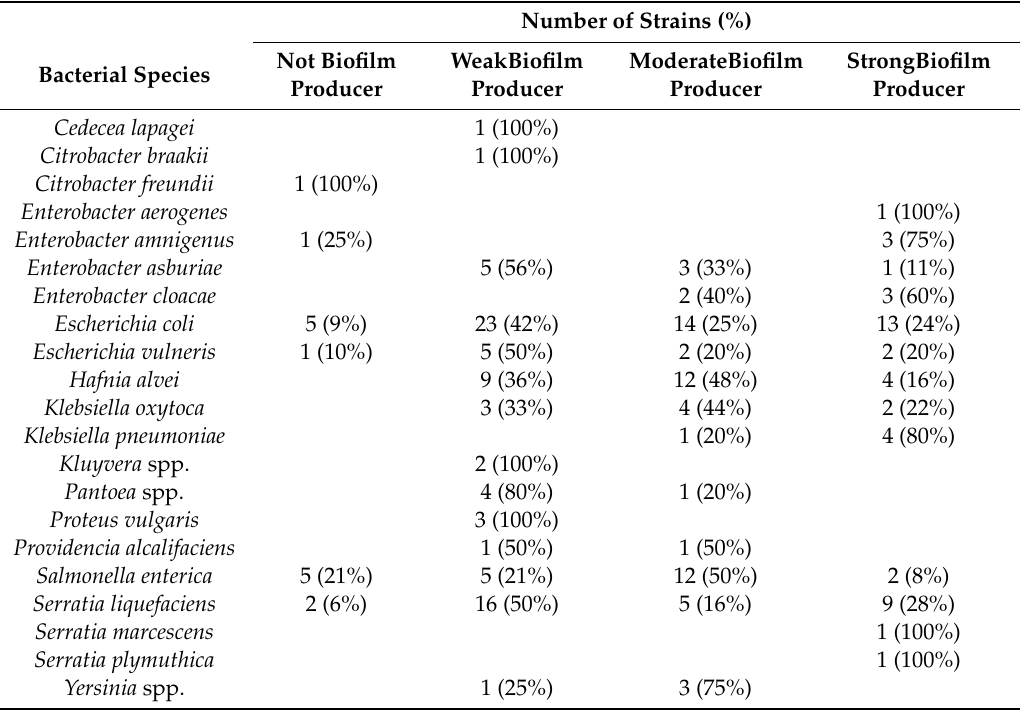
Biofilm-forming ability of di ff erent bacterial species isolated from red meat and poultry